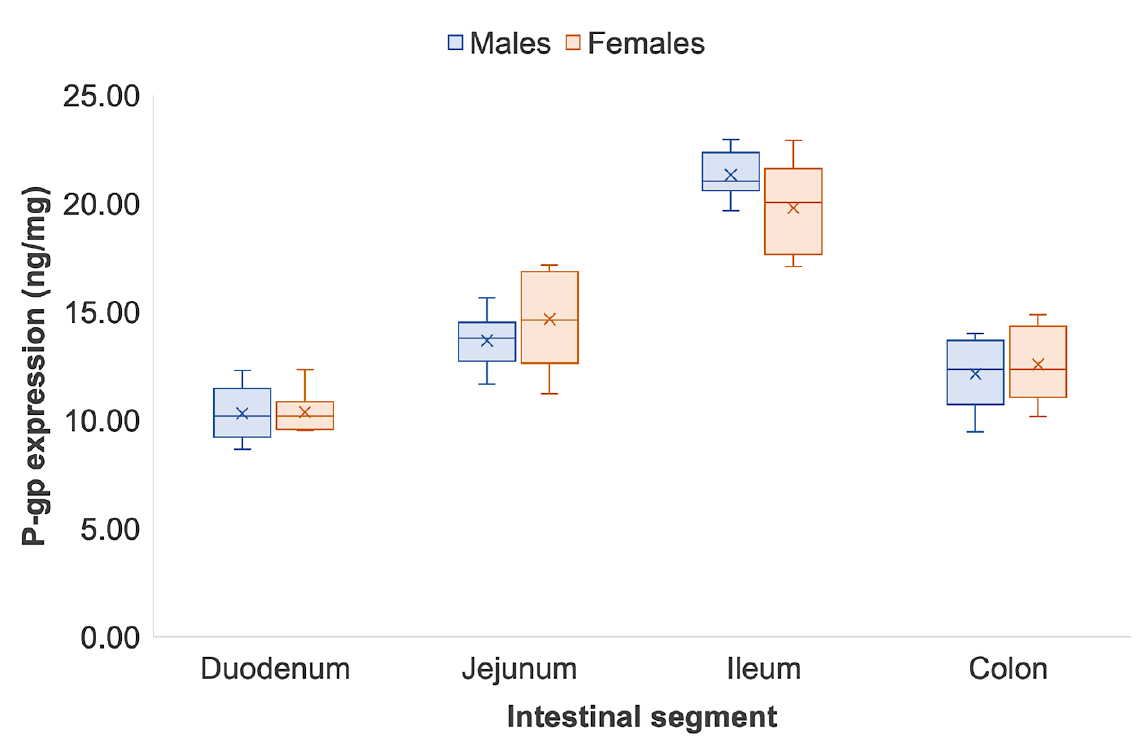
Figure 3. Regional and sex differences in P-gp expression in male and female Sprague Dawley rats quantified by ELISA. Data are represented as mean ± S.D., n = 8. Regional differences are statistically significant from the small intestinal segments to the colon ( p < 0.05).